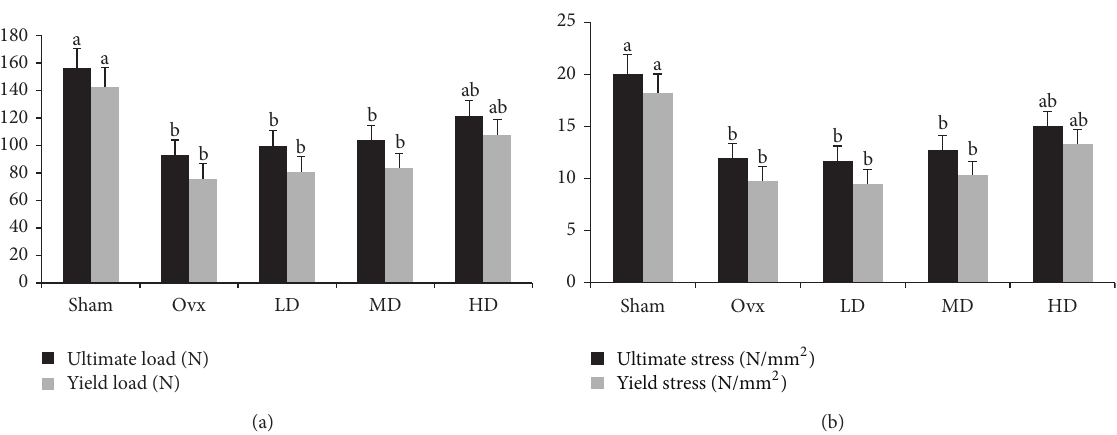
Figure 1: Effects of ovariectomy (Ovx) and three doses of vitamin E: low dose (LD, 300 mg/kg diet), medium dose (MD, 525 mg/kg diet), and high dose (HD, 750 mg/kg diet) on biomechanical parameters, (a) ultimate and yield load and (b) ultimate and yield stress of L4 vertebrae. Valuesareexpressedasmeans ± S.E.M.Valuesthatsharethesamesuperscriptlettersarenotsignificantly( 𝑃 ≥ .05 )different; 𝑛 = 12